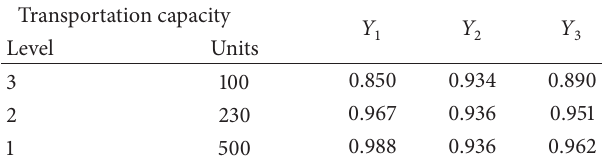
Figure 2: The changed maximum inventory levels affecting 𝑌 1 , 𝑌 2 , and 𝑌 3 . Table 3: The transportation capacity levels affecting 𝑌 1 , 𝑌 2 , and 𝑌 3 .